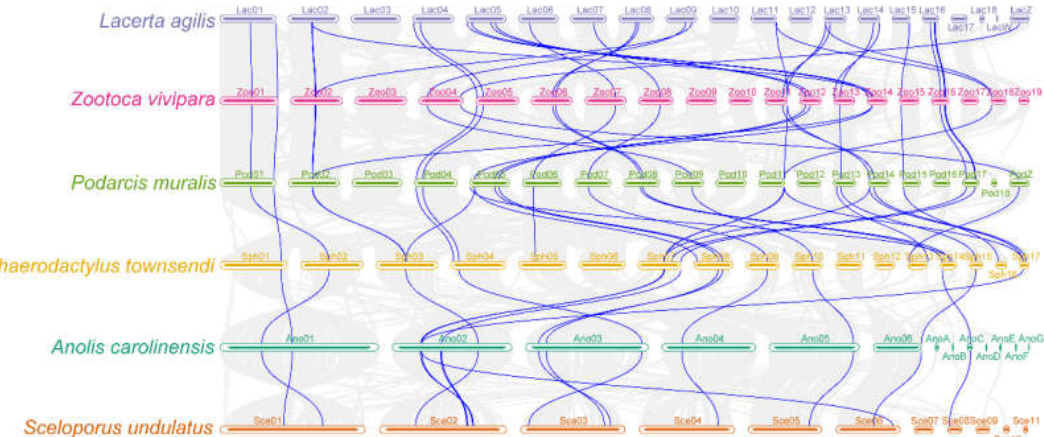
Figure 3. Synteny analysis of TRP genes among inter-genomes of saurian. The gray line in the background shows colinear blocks in the six saurian genomes, and the blue line highlights colinear TRP pairs.